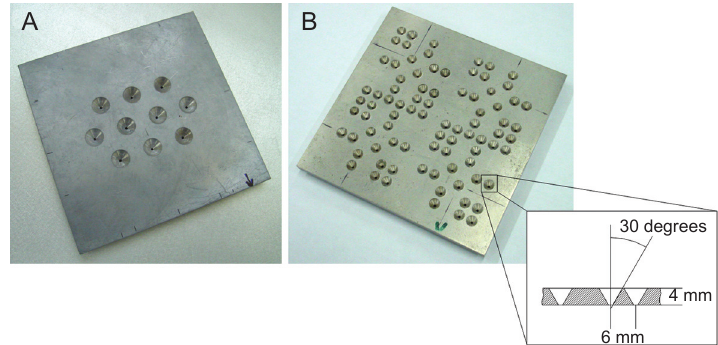
Figure 1. Multipinhole (A) and a coded mask-based (B) collimator with details of the pinhole profile. Both collimators were constructed on 4-mm thick lead plates, which guarantee transparency of less than 0.1% at 140 keV. Distances between holes and total aperture angle are 15 and 6 mm, and 90 and 60 degrees, re-